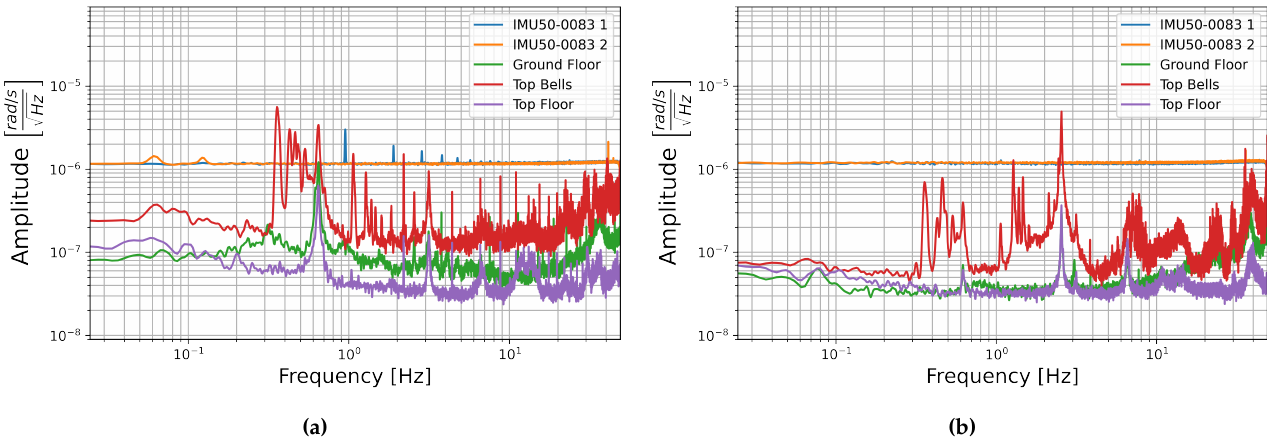
Figure 17. The square root of the PSD of self-noise recordings from sensor number 0083 compared with building noise recorded in Giotto’s Bell Tower on the Ground floor (blue), top floor (orange), and top floor with three bell tolls (green) compared for ( a ) horizontal sensor component HJY with blueSeis-3A component HJ2 and ( b ) vertical sensor component HJZ with blueSeis-3A component HJ3.